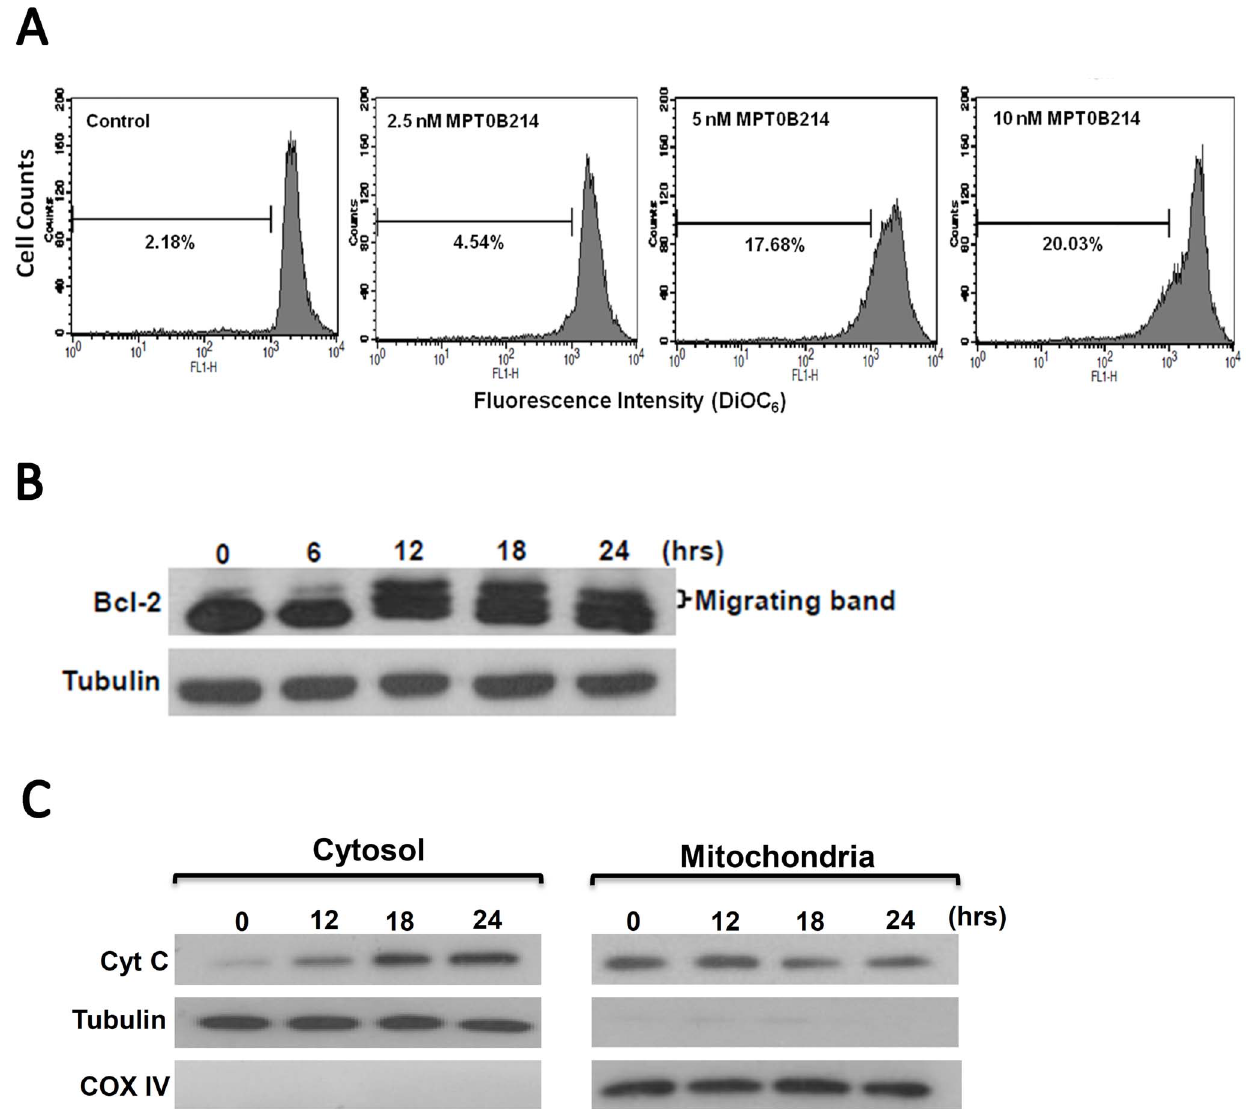
Figure 6. MPT0B214 induces changes in the mitochondrial membrane potential and initiates Bcl-2 phosphorylation, followed by cytochrome c translocation. (A) After treatment with 2.5, 5, and 10 nM MPT0B214 for 24 h, KB cells were stained with 20 nM DiOC 6 and a decrease in the mitochondrial membrane potential was determined by monitoring the uptake of DiOC 6 using flow cytometry. The X and Y axes represent the DiOC 6 fluorescence and number of cells, respectively. Cells with low DiOC 6 fluorescence were expressed as the percentage of total cell counts. (B) The effect of MPT0B214 on Bcl-2 phosphorylation. KB cells were treated with 10 nM MPT0B214 for various time points. (C) At 0, 12, 18, and 24 h of 10 nM MPT0B214 treatment, KB cells were fractionated into the cytosolic and mitochondrial fractions, as described in the ‘‘Materials and Methods’’. Protein samples were separated by SDS-PAGE for immunoblot analysis using an antibody against cytochrome c . a -tubulin and COX IV were stained as the internal control of cytosolic and mitochondrial fractions.